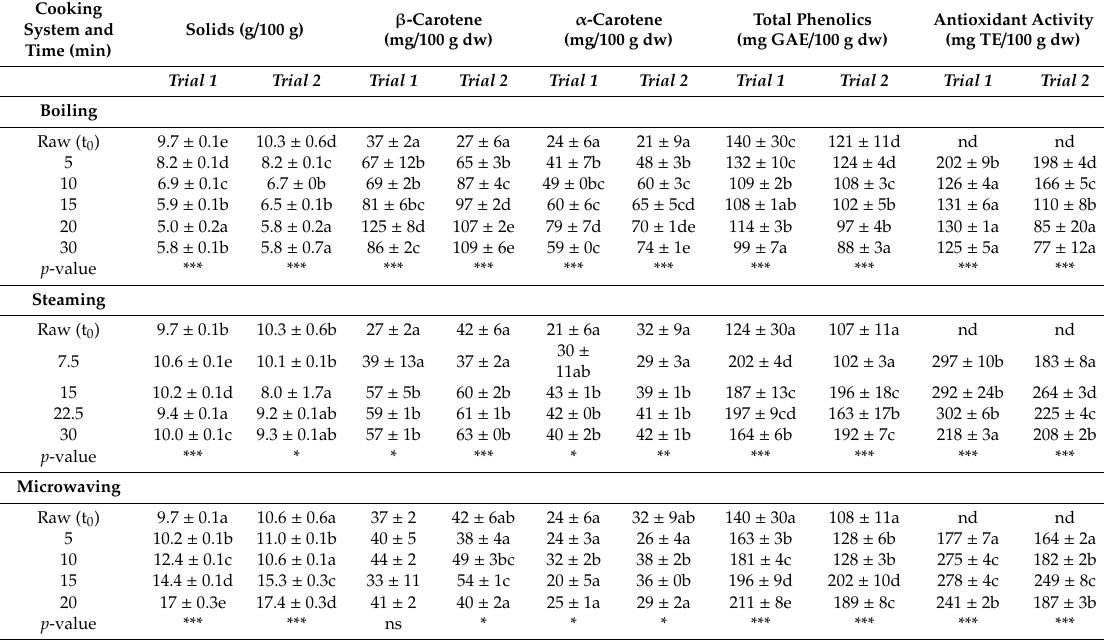
Table 2. Nutritional properties of carrots cooked by di ff erent cooking systems and